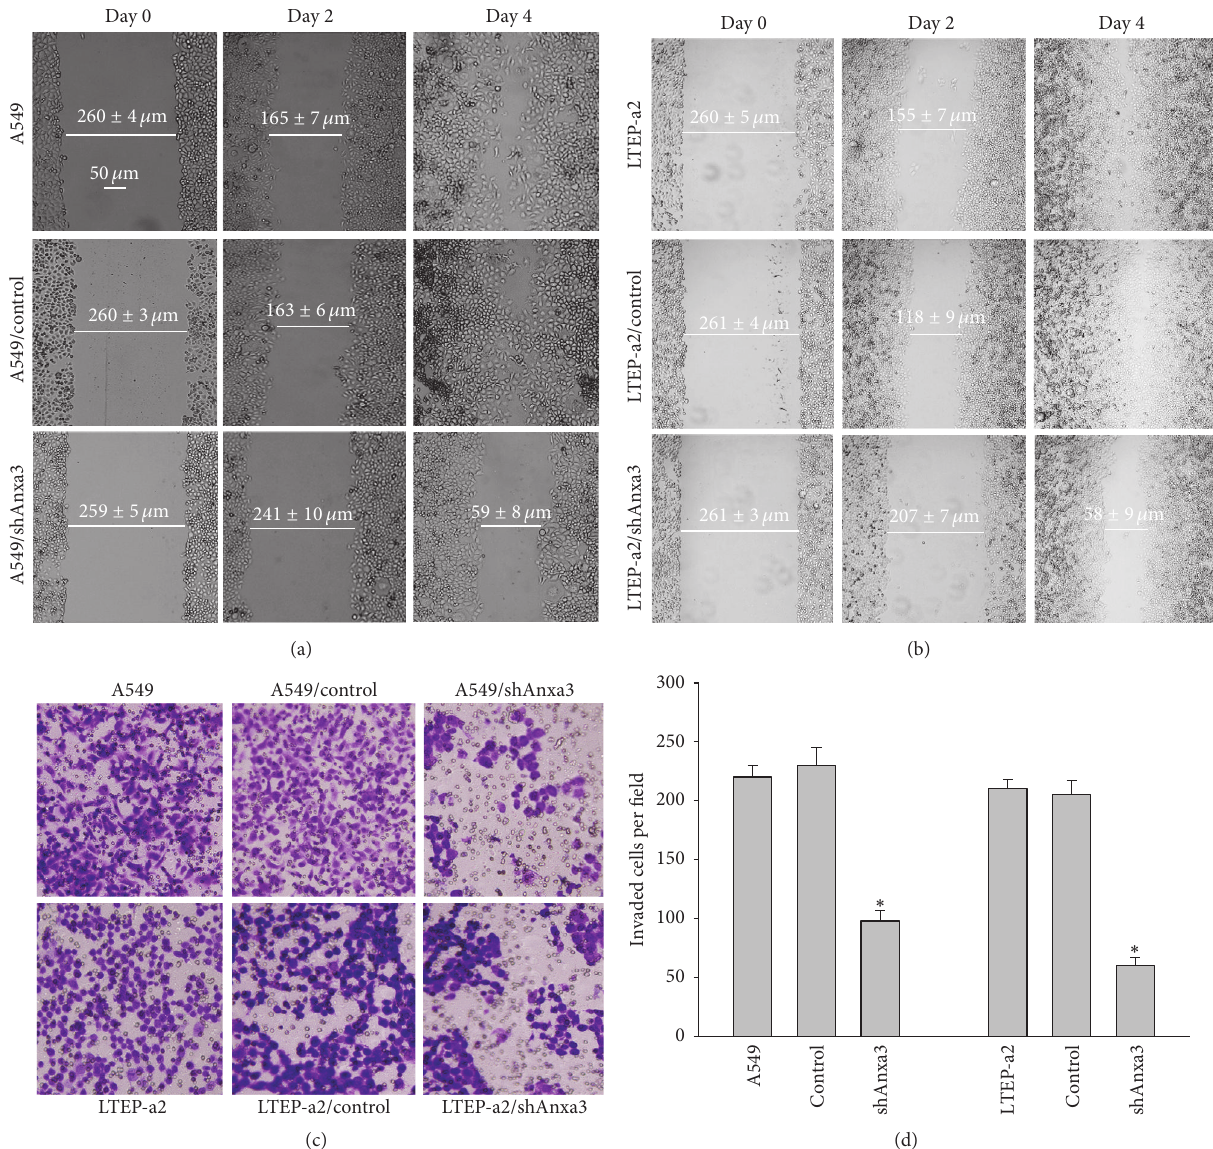
Figure 2: Wound healing assays indicated that downregulating Anxa3 expression inhibited the migration of A549 (a) and LTEP-a2 (b). Magnification: × 100. Transwell assay (c) and analysis of histograms (d) of the numbers of invaded cells indicated that downregulating Anxa3 expression significantly decreased the invasive behavior of LADC cells. Magnification: × 200. ∗ indicates 𝑝 < 0.05 .